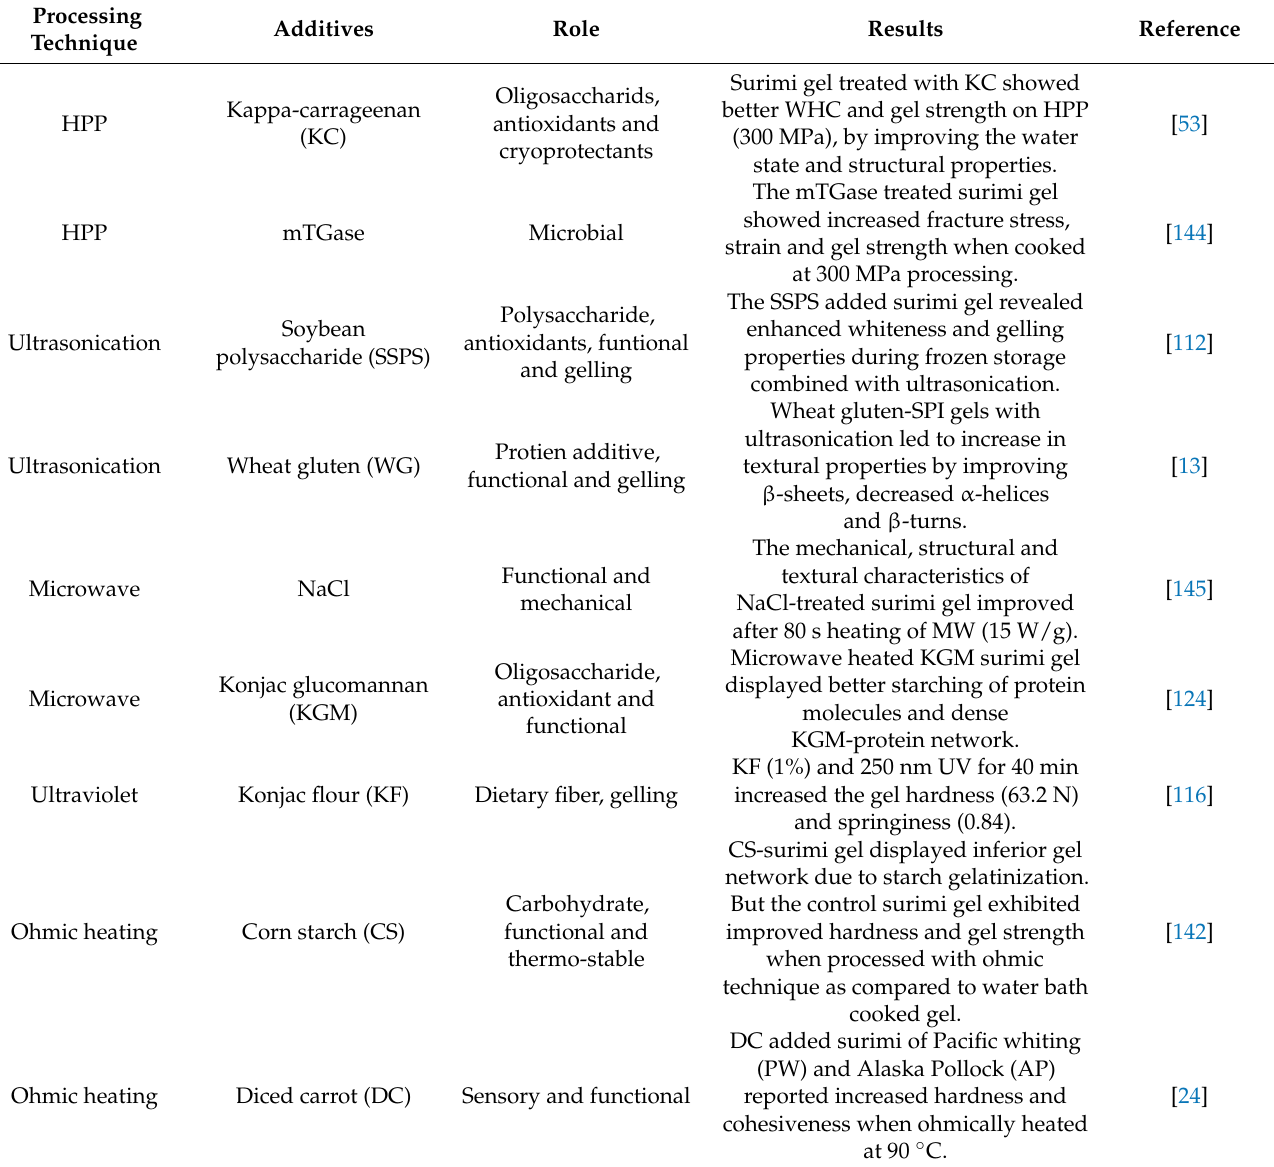
Table 2. Role of modern processing techniques on enhanced textural properties of surimi